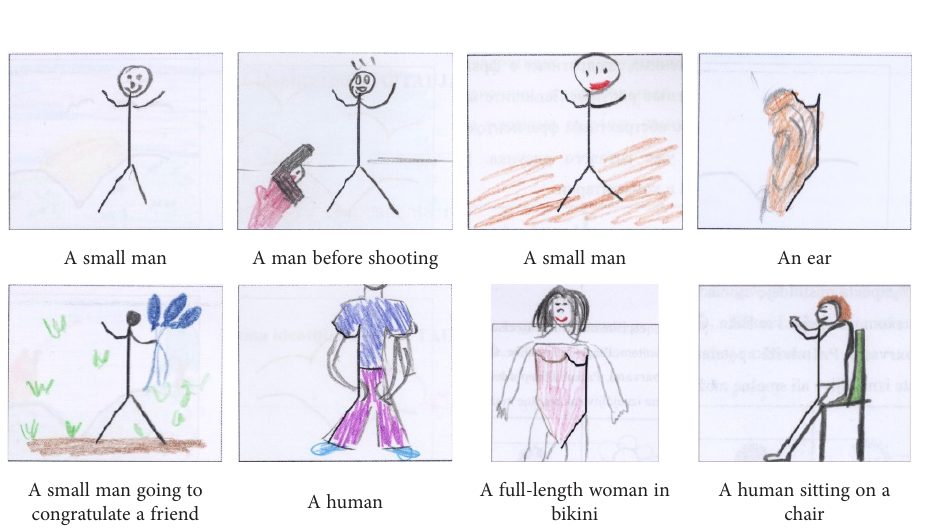
Figure 29. The creative task: interpretation of Fragment 5 – human being (source: testingmom.com 2020)